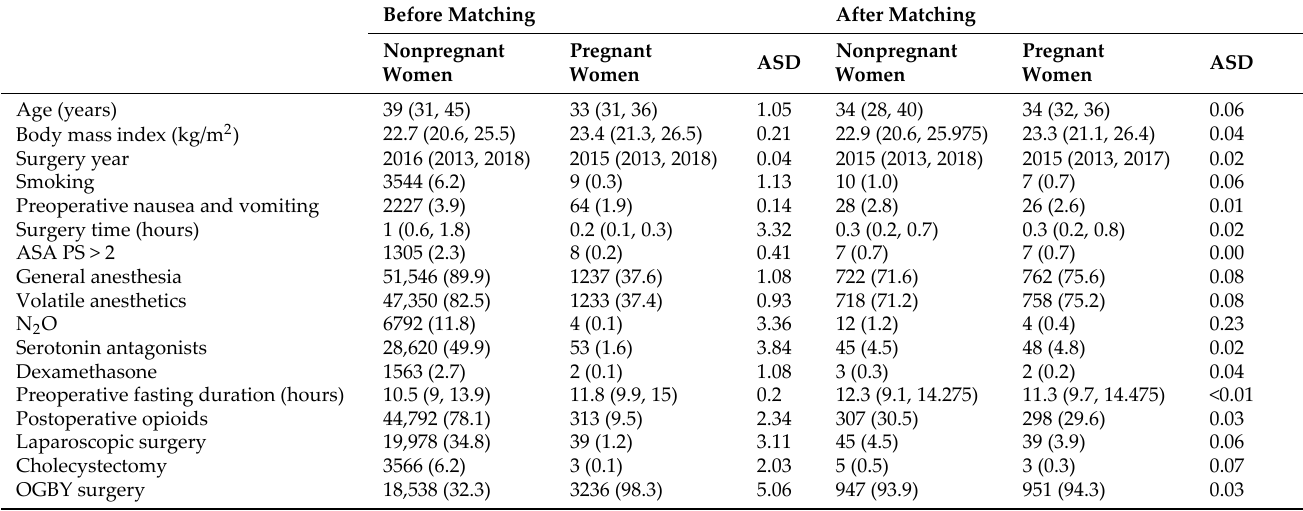
Table A4. Characteristics of variables before and after propensity score matching. ASD, absolute standardized differences; ASA, American Society of Anesthesiologists; PS, physical status; OBGY, obstetric and